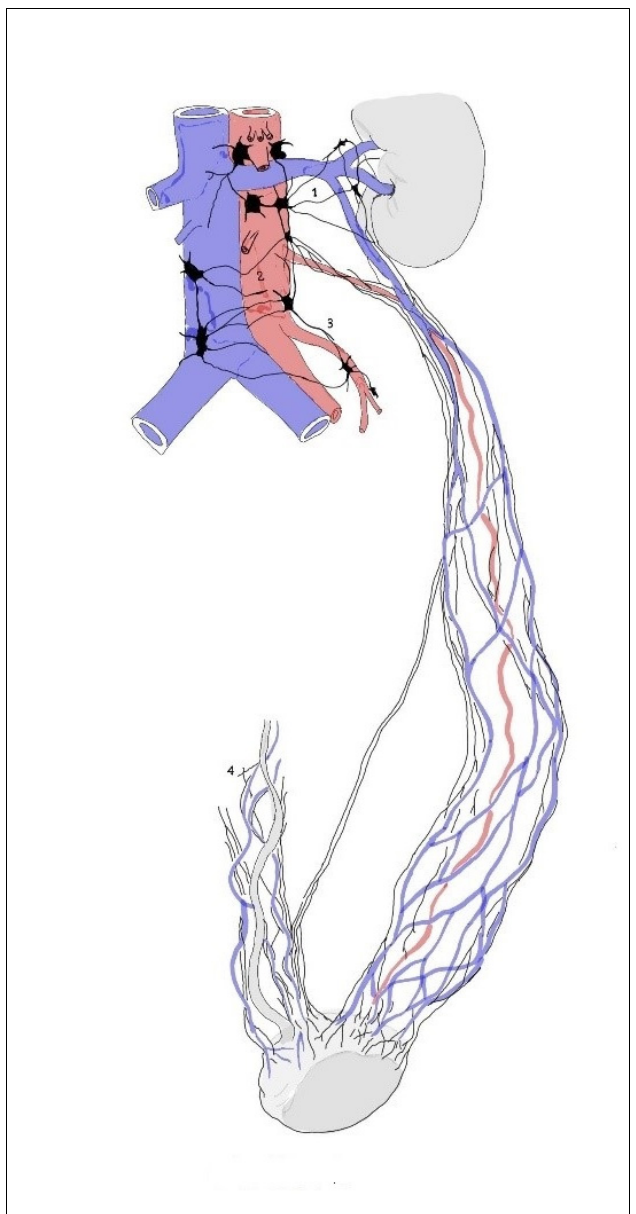
Figure 7. In the concentric type, the ganglionic masses are concentrated in a smaller number of large nodes. Connections between the plexus nerves on the periphery are less common. When the ganglionic masses are concentrated in a smaller number of large nodes, forming the renal plexus (1), aortic plexus (2), and mesenteric plexus (3), the spermatic plexus consists of a smaller number of thin nerves arising mainly from the renal and aortic plexuses. Between the nerves at the periphery of the plexus, the connections are less common. In similar cases, the connections of the spermatic plexus with the deferential plexus (4) are also rare. The other images show the significant asymmetry of the pelvic plexus in men (Figure 8) and asymmetric formation of the uterovaginal plexus in women (Figure